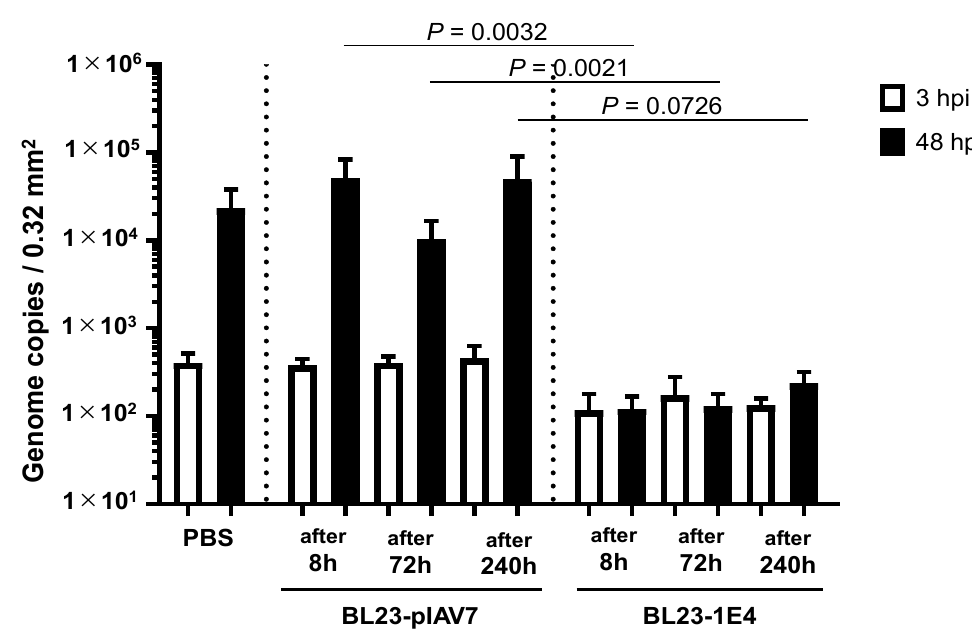
Figure 4. Neutralization of norovirus GII.17 in vitro by Lactobacillus BL23-IE4 that was collected from the feces of germ-free mice orally inoculated with 1E4 nanobody-displaying Lactobacillus (BL23-IE4). We incubated 2 × 10 6 genome equivalents of GII.17 (Kawasaki308) human norovirus with 3 × 10 6 cells of L. paracasei BL23-pIAV7 or BL23-1E4 for 2 h before using them to inoculate human intestinal epithelial cells. After inoculation, the cultures were incubated for 48 h in the presence of bile. Each data point is representative of at least 3 independent experiments, and data are shown as the mean ± 1 SD of 6 wells of supernatant from each culture